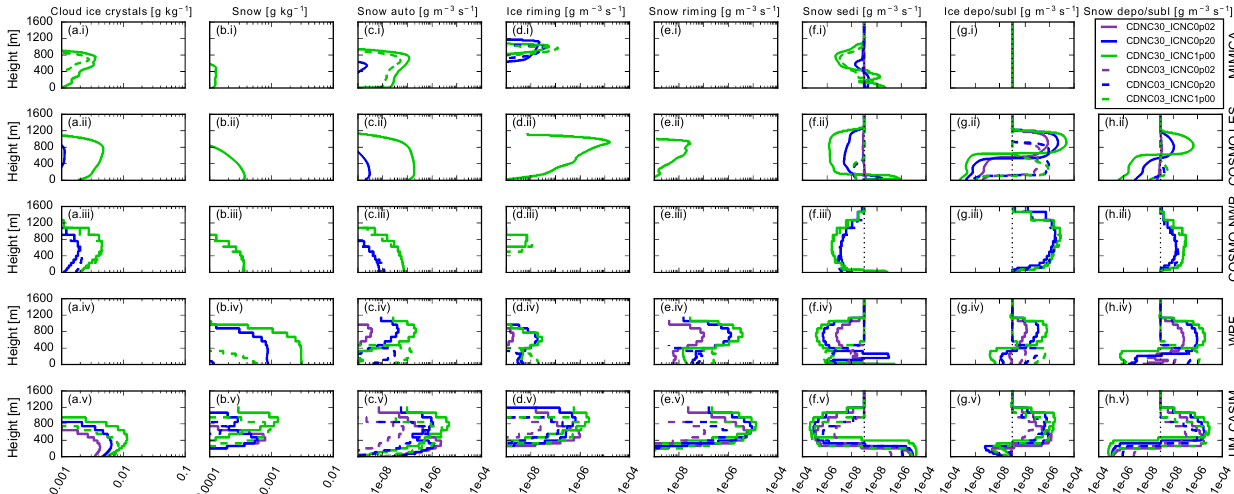
Figure 13. Tendencies of ice and snow mass due to processes affecting frozen cloud mass for the prescribed CDNC simulations. The first letter in subplot labels refers to column and the second to the row. Mass mixing ratios of cloud ice (a) and snow (b) , tendencies of cloud ice and snow mass due to autoconversion to snow (c) , riming by cloud ice (d) , riming by snow (e) , sedimentation of snow (f) , deposition + sublimation of cloud ice (g) , and deposition + sublimation of snow (h) . Results shown (from top to bottom) for MIMICA (i) , COSMO-LES (ii) , COSMO-NWP (iii) , WRF (iv) , and UM-CASIM (v)